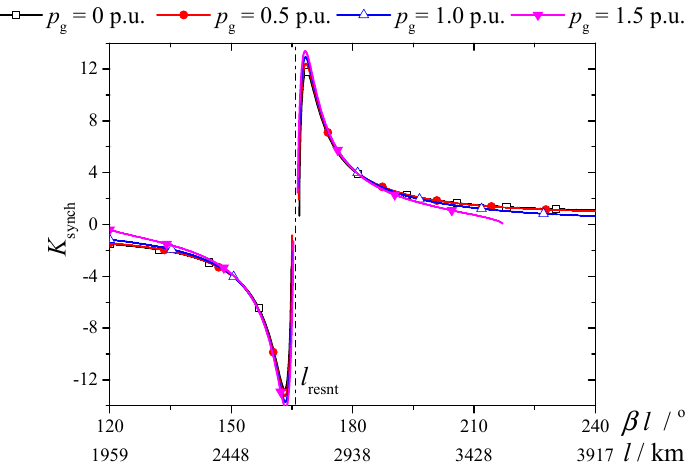
Figure 5. K synch of different transmission power and transmission distances.